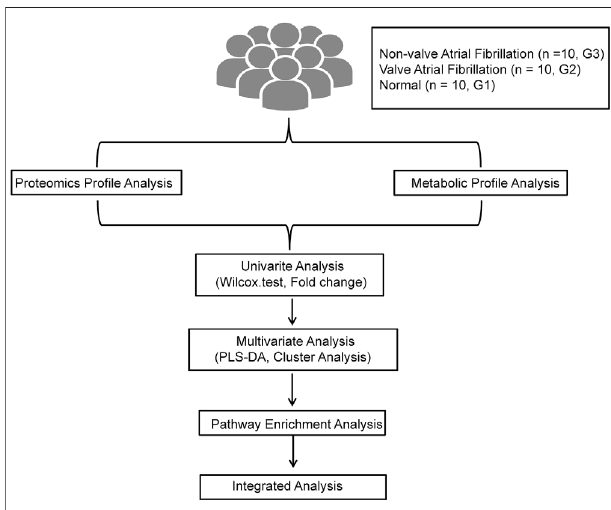
FIGURE 1 | The fl owchat of the analysis in this